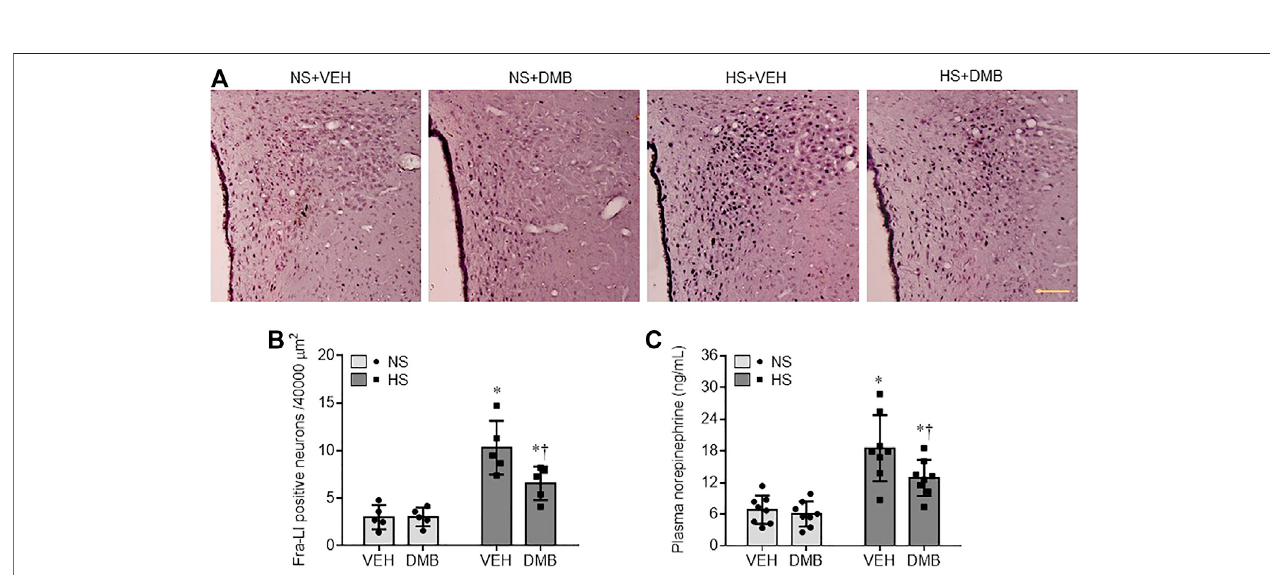
FIGURE 6 | Representative images of immunohistochemistry showing Fra-LI immunoreactivity (A) , a marker of neuronal excitation and quanti fi cation of Fra-LI positive neurons in the PVN (B) , and plasma levels of norepinephrine (C) , a marker of sympathetic nerve activity, in rats fed a normal salt (NS) diet or a high salt (HS) diet and simultaneously treated with vehicle (VEH) or 1.0% 3,3-Dimethyl-1-butanol (DMB, an inhibitor of trimethylamine formation). Dark dots in A indicate single activated neurons. Scale bar = 100 μ m. All data are expressed as mean ± SEM ( n = 5-8 rats/per group). p p < 0.05 vs . NS + VEH; † p < 0.05, HS + DMB vs . HS + VEH.